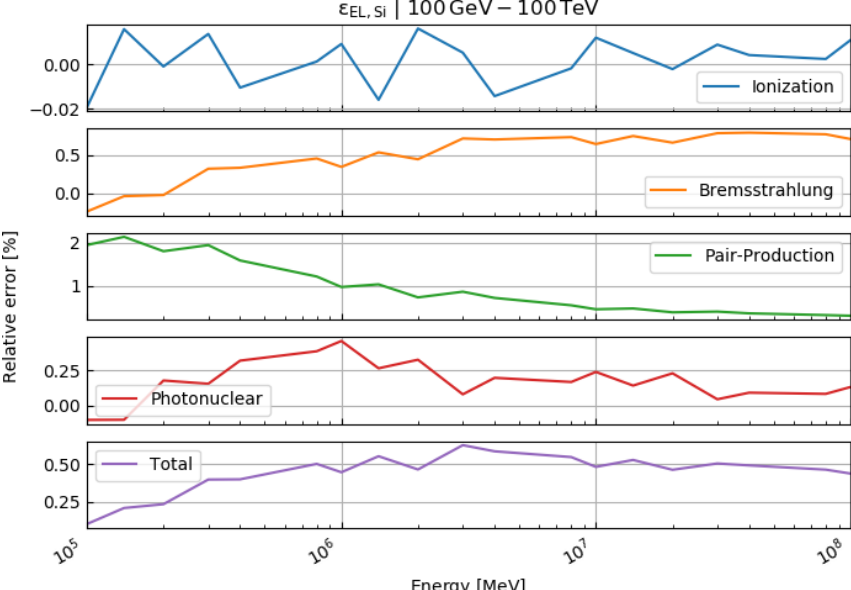
Figure E3. Relative error of our energy loss calculations for silicon compared to the tabulated values from Groom et al. (2001) at higher energies (100GeV–100TeV). The relative errors remain bounded within their theoretical uncertainties (see Sect. 3.1.3).